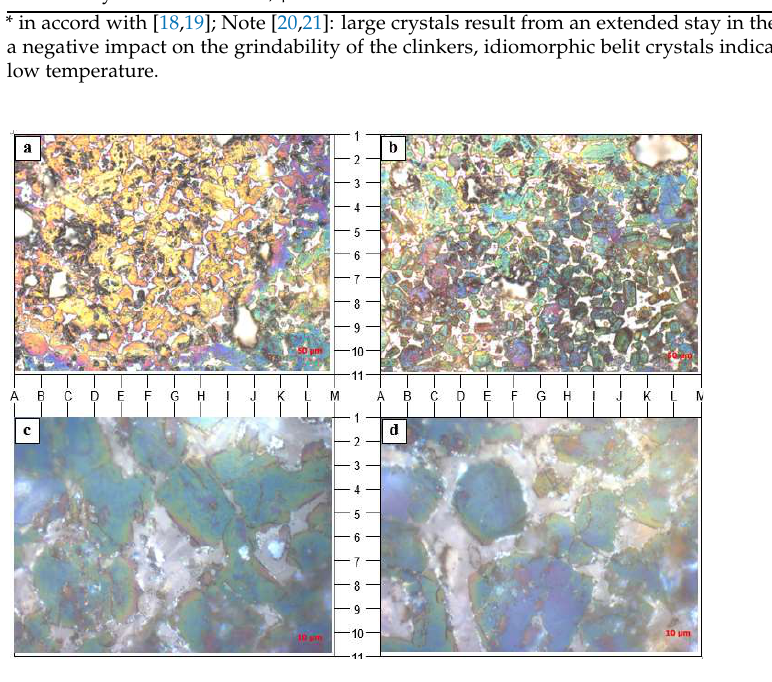
Figure 5. Microphotographs representing the morphology of alite crystals present in the clinker. Enlarge images: ( a , b ) M200X; ( c , d ) M1000X.